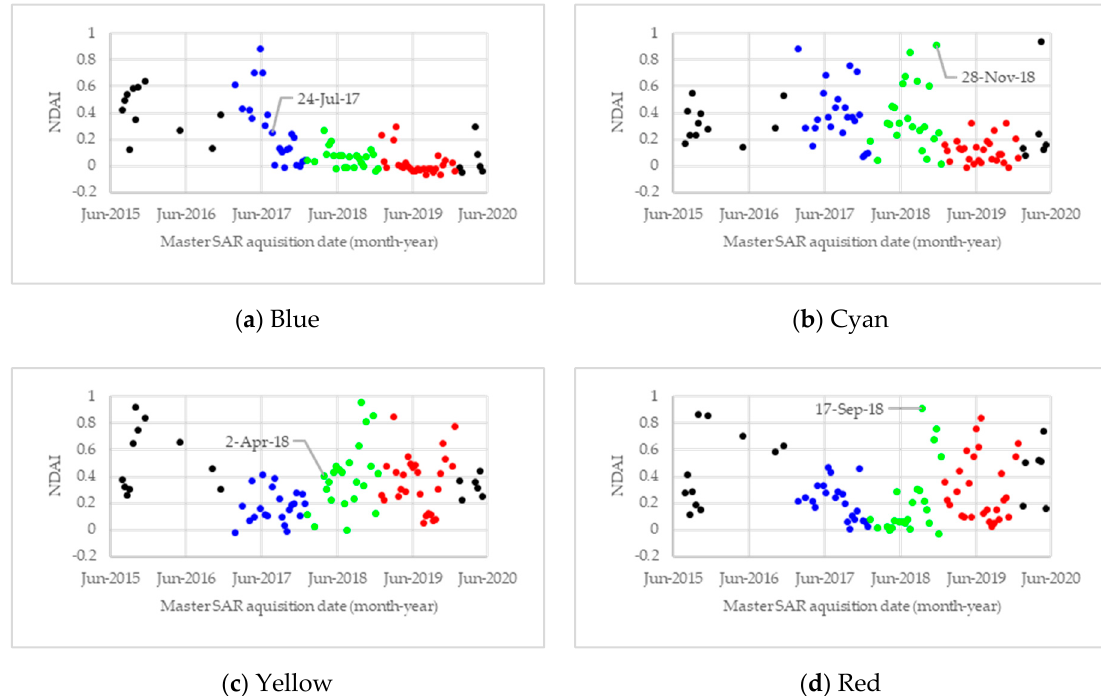
Figure 14. The 12-day NDAI time-series graphs of WD1 showing the detailed activation or deactivation date in ( a ) blue (B), ( b ) cyan (C), ( c ) yellow (Y), and ( d ) red (R) points in Figure 13c. The red, green, and blue dots in the graphs indicate the data used for generating the RGB composite of the annually averaged NDAI images, while black dots were not.